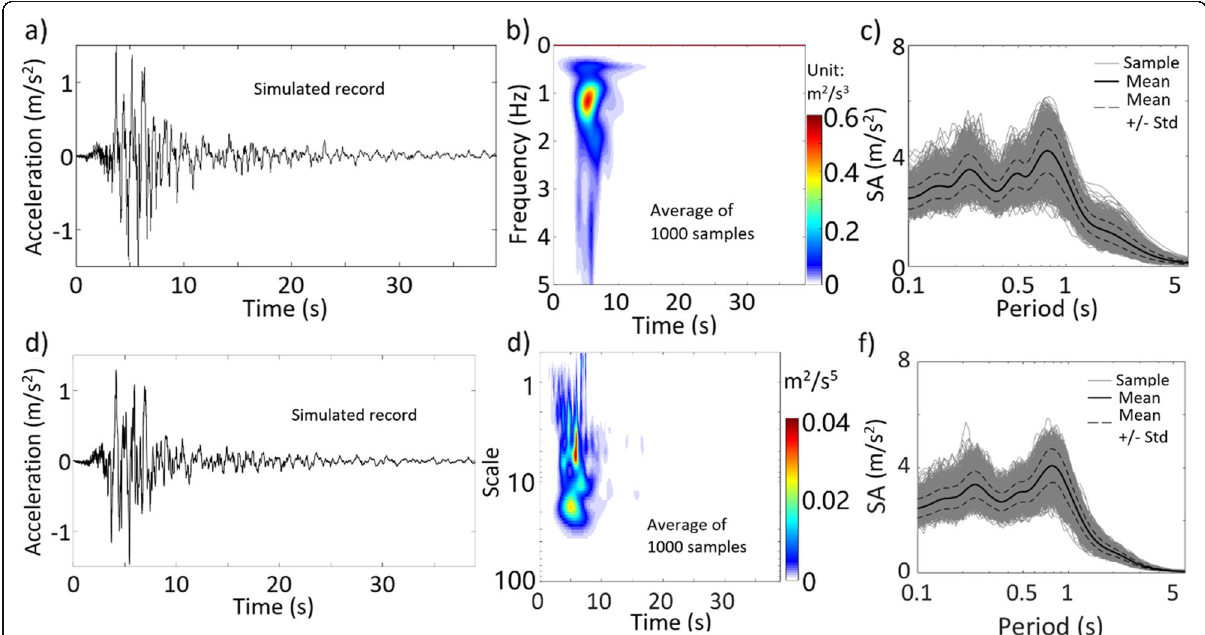
Fig. 10 Results based on simulated nonstationary Gaussian records by using ST and WT (the results presented in a to c are for ST, and the results presented in d to f are for WT): a a sampled record based on ST, b average TFPSD of the 1000 sampled record, c SA from 1000 sampled records using ST, d a sampled record based on WT, e average TSPSD of the 1000 sampled record, f SA from 1000 sampled records using